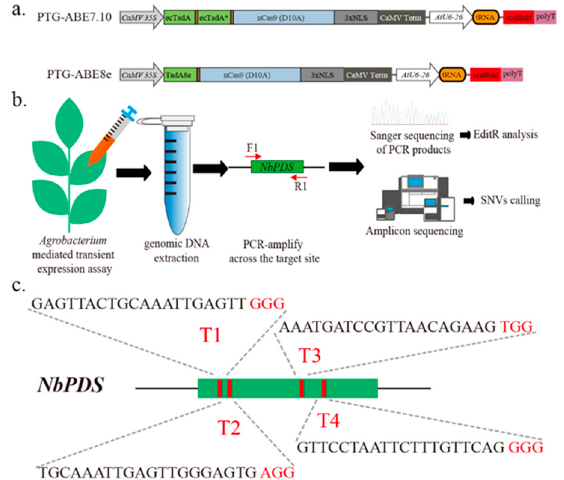
Figure 1. Overview of A-to-G base editing by different ABEs in N. benthamiana . ( a ) Schematic depicting the PTG-ABE7.10 and PTG-ABE8e structure. NLS, nuclear localization sequence. ( b ) Assay scheme of agrobacterium-mediated transient expression and base-editing identification. F1/R1 indicates binding sites of the primers used for species-specific PCR amplification. ( c ) Schematic illustrating the four sgRNAs targeting the NbPDS gene. Red letters indicate the PAM sequence of